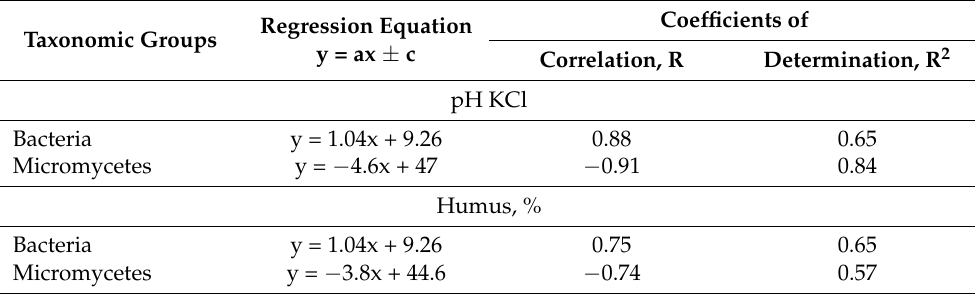
Table 4. Influence of the soil pH and humus content in the 0–20 cm layer of sod-podzolic soil on the number of microorganisms of the main taxonomic groups averaged from